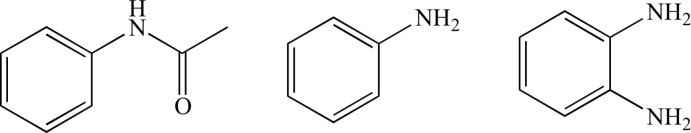
Sketches of a phenyl­amide, a phenyl­amine and a 1,2-phenyldi­amine.